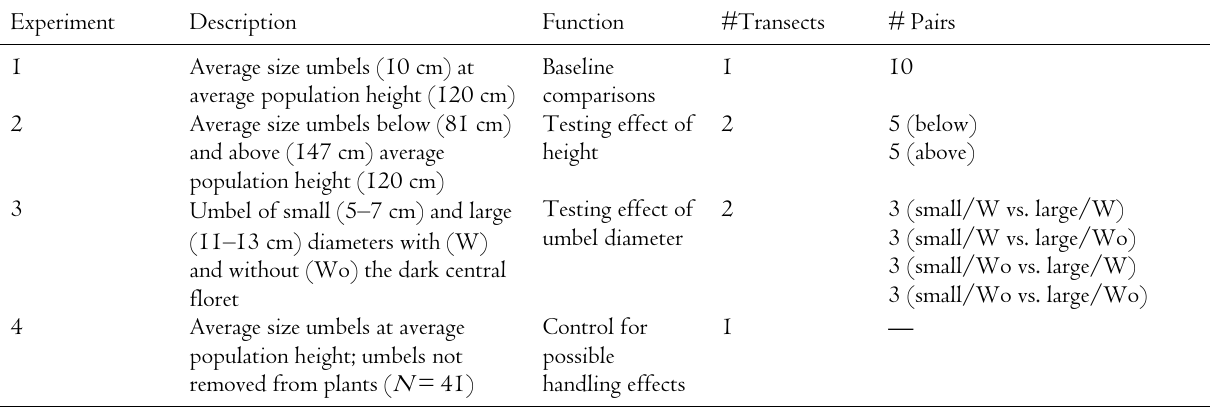
Table 1. Summary of experiments conducted on a coastal population of Daucus carota L. in western Turkey. We completed Experiments 1 – 3 on two days, each day using a new umbel, and Experiment 4 on the same day and same umbel, after the removal of the dark central floret. — = not applicable, as the same umbel was compared before and after the removal of the